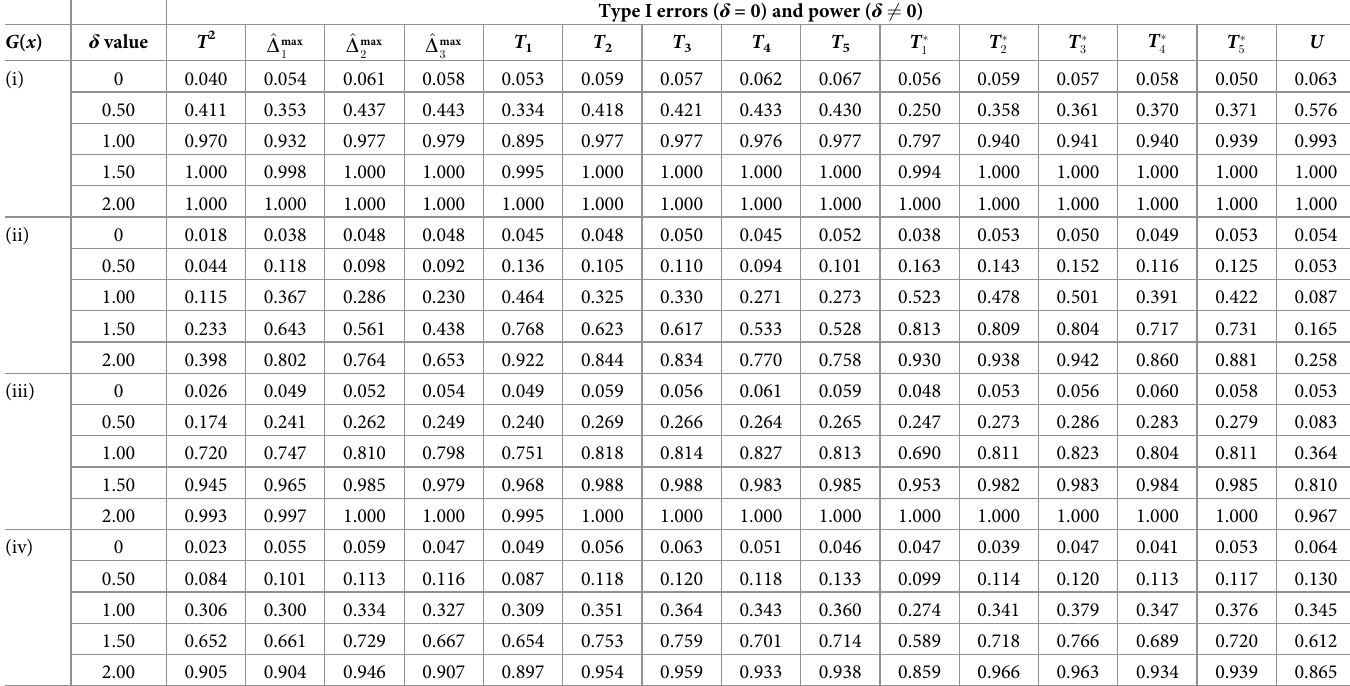
Table 1. Type I errors ( δ = 0) and power ( δ 6¼ 0) given by the investigated test statistics based on permutation approach in detecting location shift between two sam- ples generated from the four pairs of F ( x )and G ( x )with variance-covariance matrix I 4×4 and sample sizes n = m =